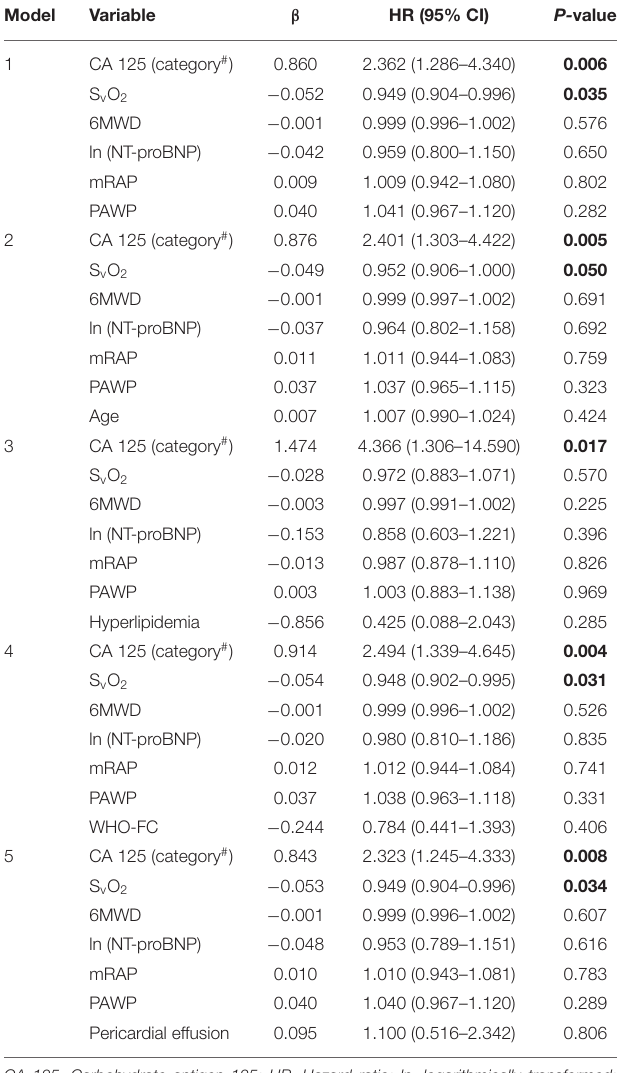
TABLE 4 | Multivariate cox analysis of proportional risks for 1-year clinical worsening. Model